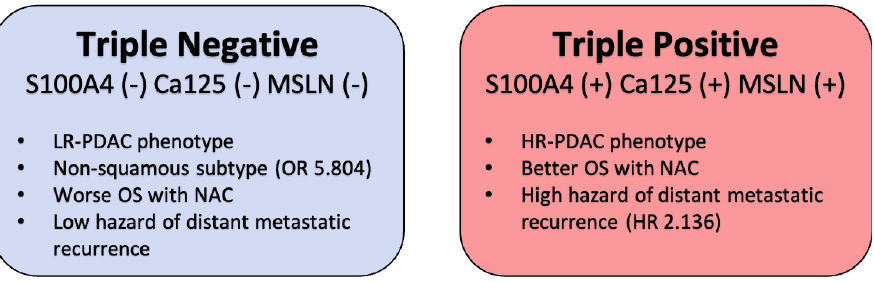
Figure 2. Summary of findings: LR-PDAC, low-risk pancreatic ductal adenocarcinoma; HR-PDAC, high-risk pancreatic ductal adenocarcinoma; OS, overall survival; NAC, neoadjuvant chemotherapy.